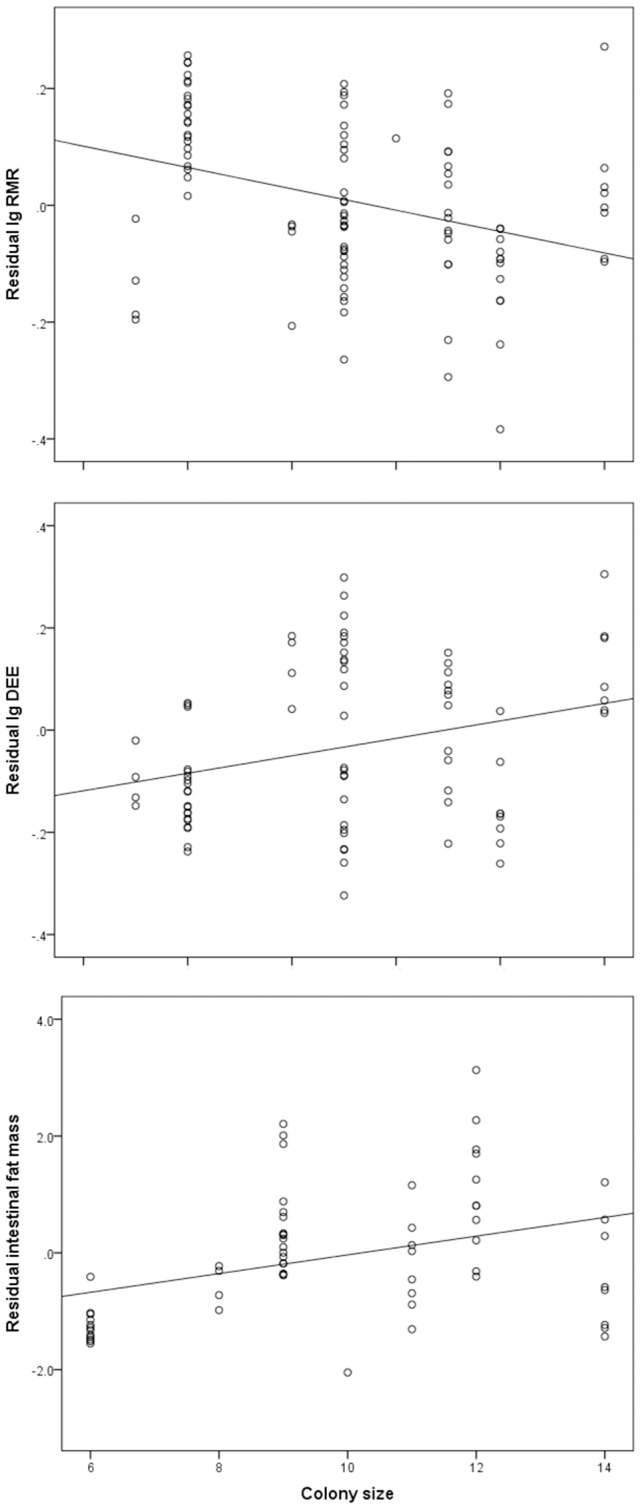
Correlations between group size and energetic measures.(a) Resting metabolic rate against colony size (residual log10RMR, kJ/day); (b) Daily energy expenditure against colony size (residual log10DEE, kJ/day); and (c) Fat mass against colony size (residual fat mass, g) of C. h. natalensis.